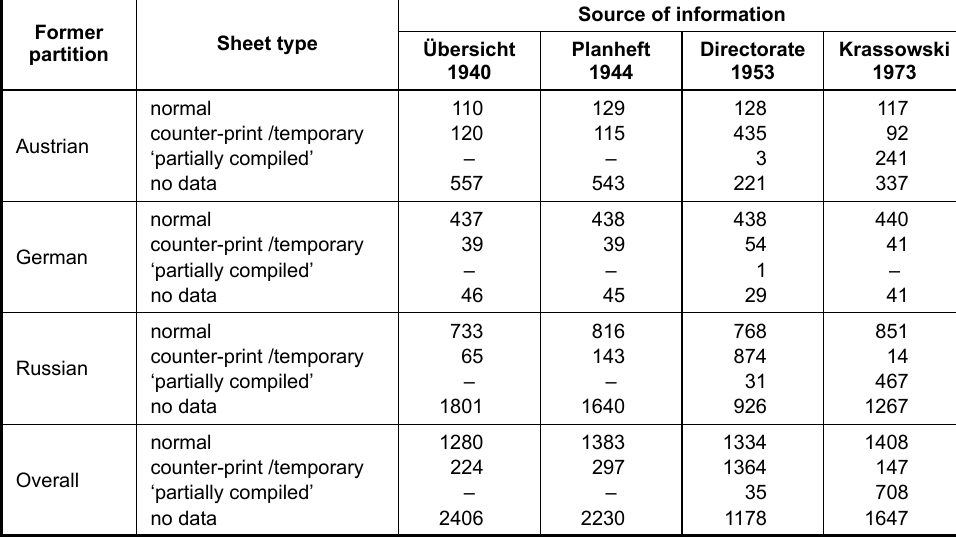
Tab. 2. MGI’s 1:25,000 detailed map sheet types according to different